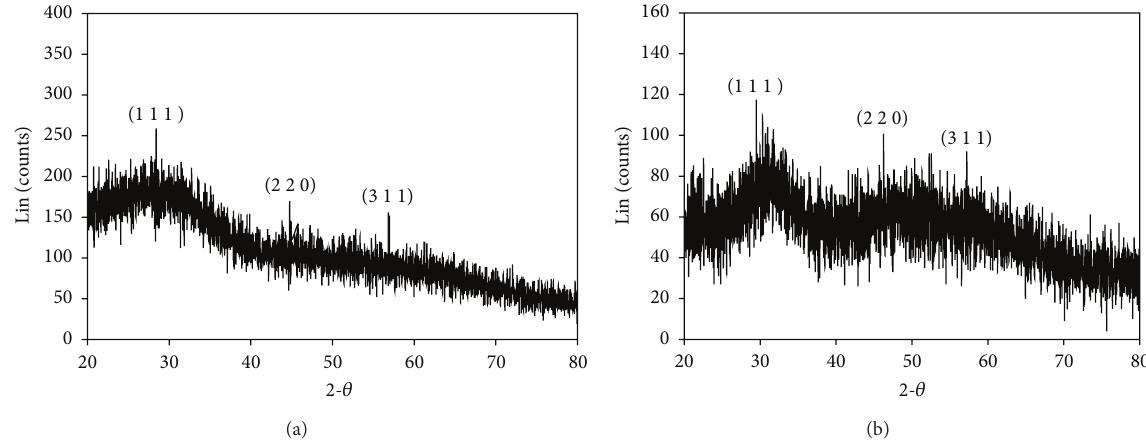
Figure 3: XRD pattern of sulfide nanoparticles synthesized by K. pneumoniae : (a) CdS and (b)